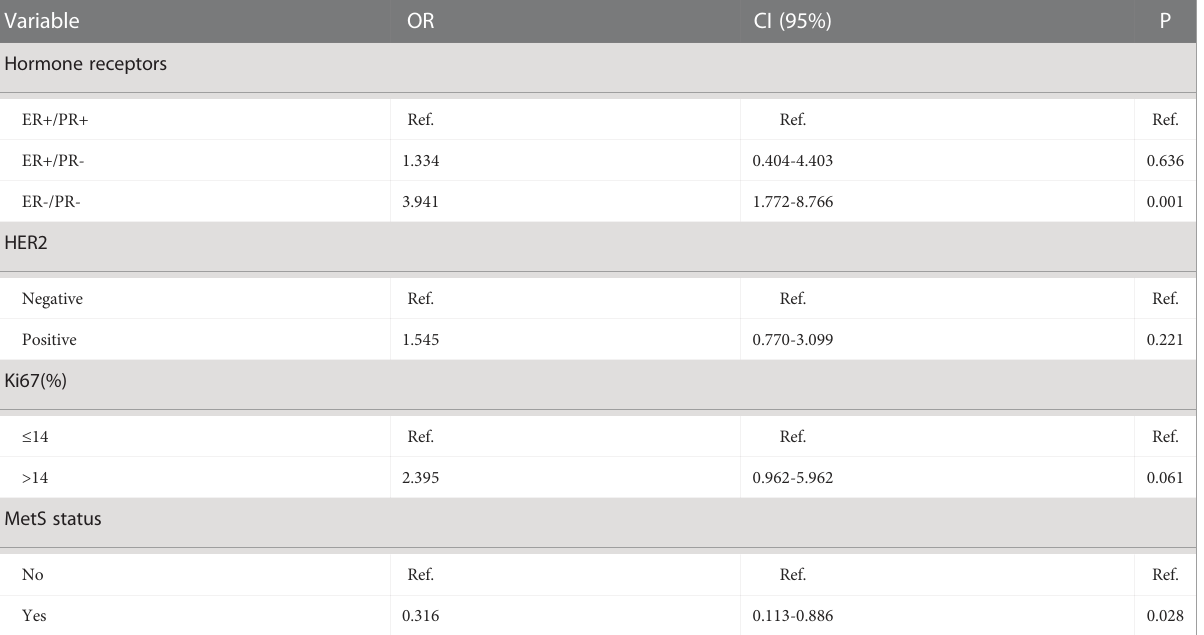
TABLE 3 Multivariate analysis between clinical characteristics and pCR.